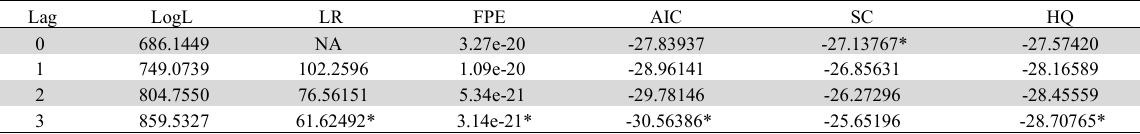
Defining latency in the model